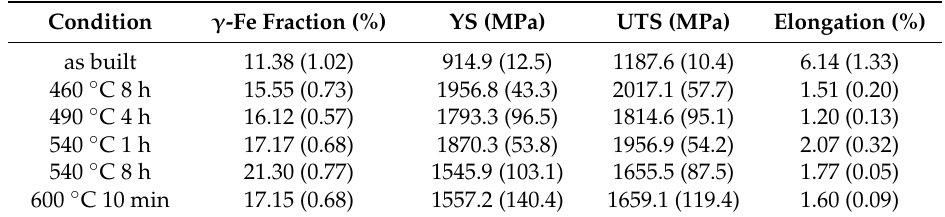
Figure 8. XRD spectra of the 18-Ni 300 steel as a function of aging condition. Table 2. Austenite ( γ -Fe) fraction and corresponding tensile properties as a function of aging temper. Standard deviation of data is also given in brackets.